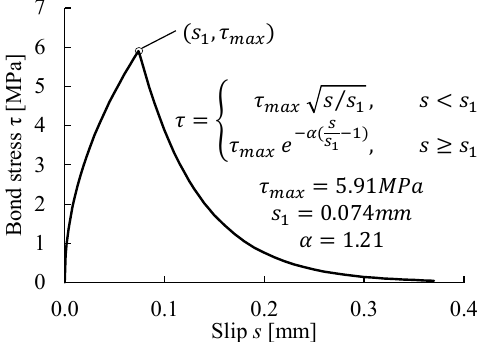
Figure 9. Bond–slip model assigned between the CFRP plate and concrete.